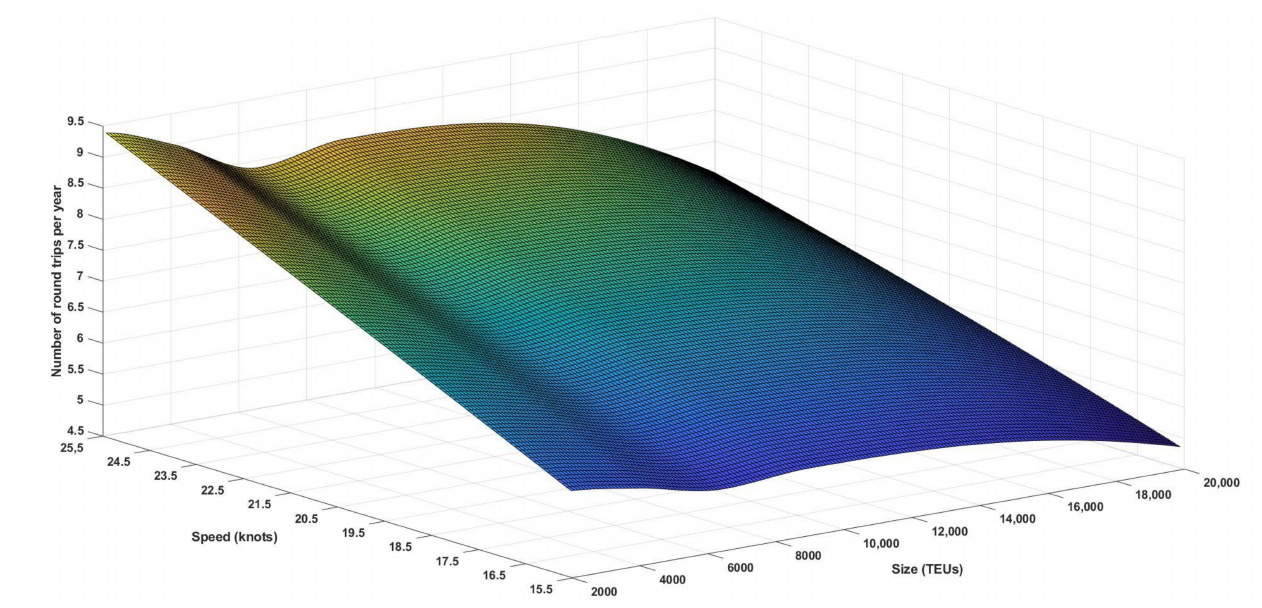
Figure 4. Number of round trips as a function of size (TEUs) and speed (knots). The Equation (12) to be optimised also depends on five variables shown in Table 5. For